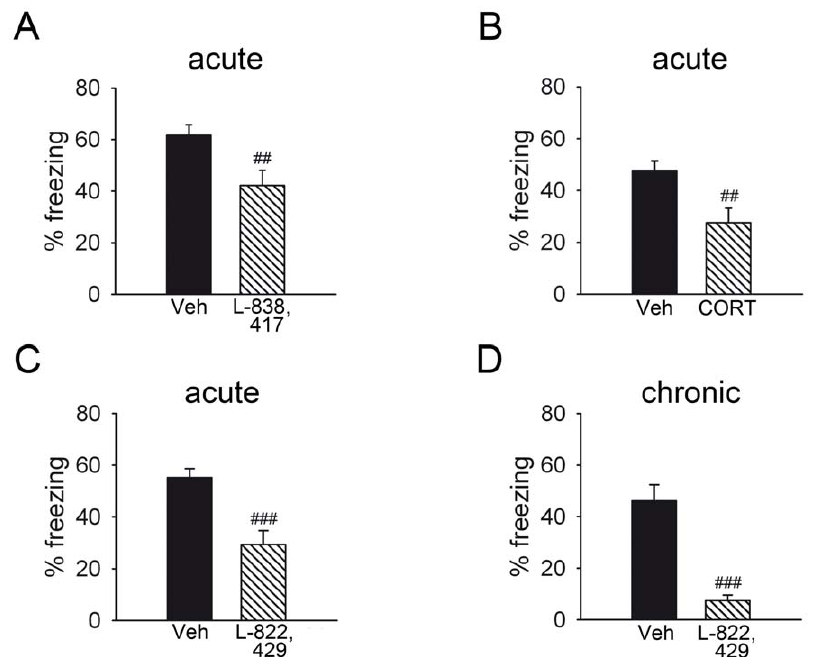
Figure 4. Pharmacological modulation of learned cued fear in HAB mice. An acute application of either the a 2,3,5 -subunit selective benzodiazepine partial agonist L-838,417 (1 mg/kg; A), corticosterone (CORT; 10 mg/kg; B) or the selective NK1 receptor antagonist L-822,429 (30 mg/kg; C) 30 min prior to testing reduced fear expression as indicated by the percentage of freezing displayed by HAB mice during fear expression. Chronic treatment with L-822,429 (30 mg/kg/day; D) attenuated CS-induced freezing levels even more. Data are presented as means 6 SEM. n =7–10 per experimental group. ## p , 0.01, ### p , 0.001 drug vs. vehicle.